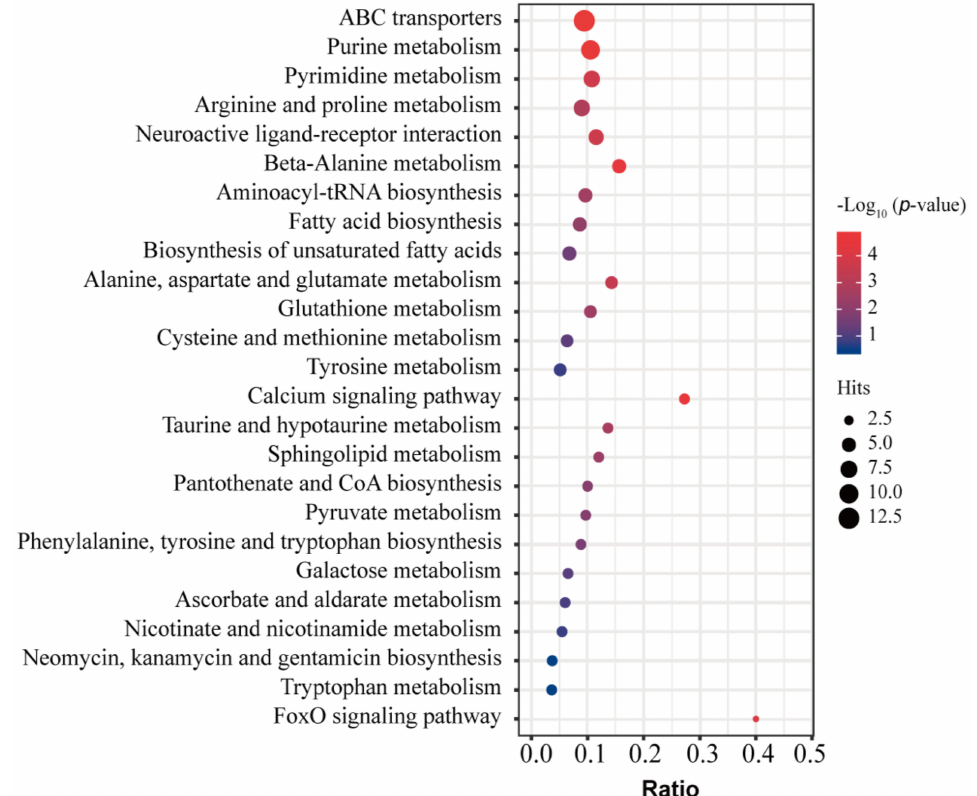
Figure 4. The top 25 significantly enriched KEGG pathways based on the differential metabolites in the uropygial gland between male and female ducks. The dot size represents the number of different metabolites in the corresponding pathway. The larger the dot, the more differential metabolites enriched in the pathway. The ratio is the number of differential metabolites in the corresponding signal pathway to the total number of identified metabolites. Bubbles with different colors indicate the degree of